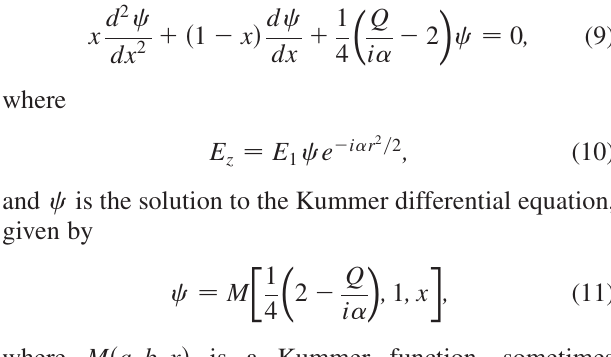
ð a; b; x Þ [23]. The second linearly independent solution 1 F 1